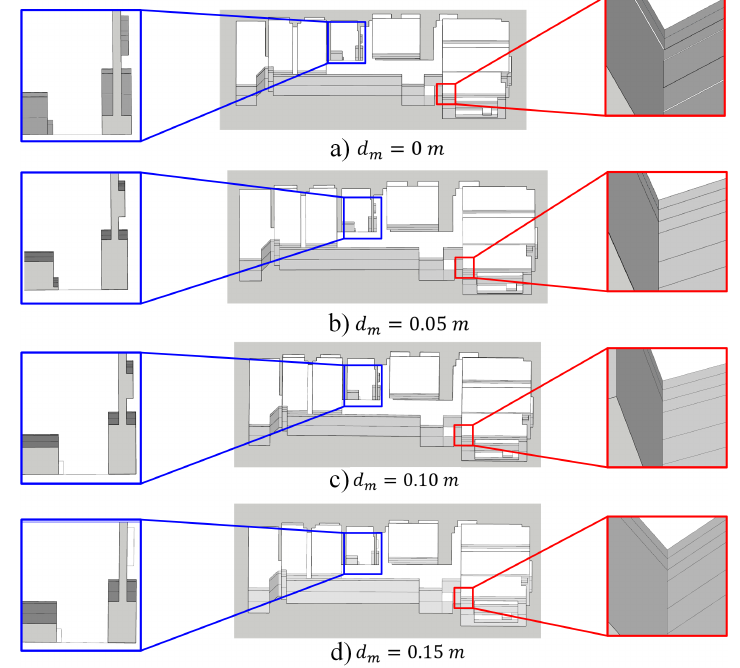
Figure 23. The effects of the merging parameter d m to the final model: From 0 cm to 15 cm. ( a ) zig-zagging model without mergence; ( b ) proper merging parameter keeps the details of building; ( c , d ) details discard because of the